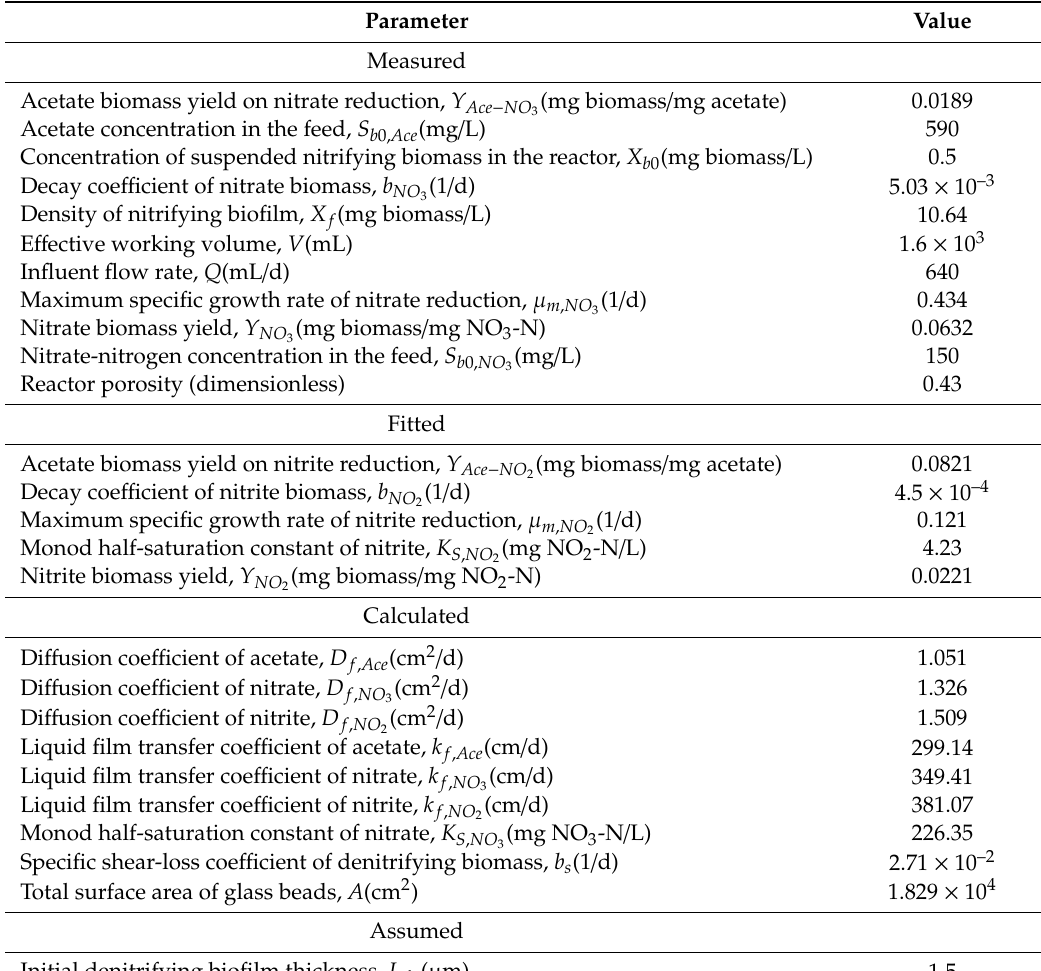
Table 2. Biokinetic and reactor parameters as well as mass transfer coe ffi cients used in the biofilm model